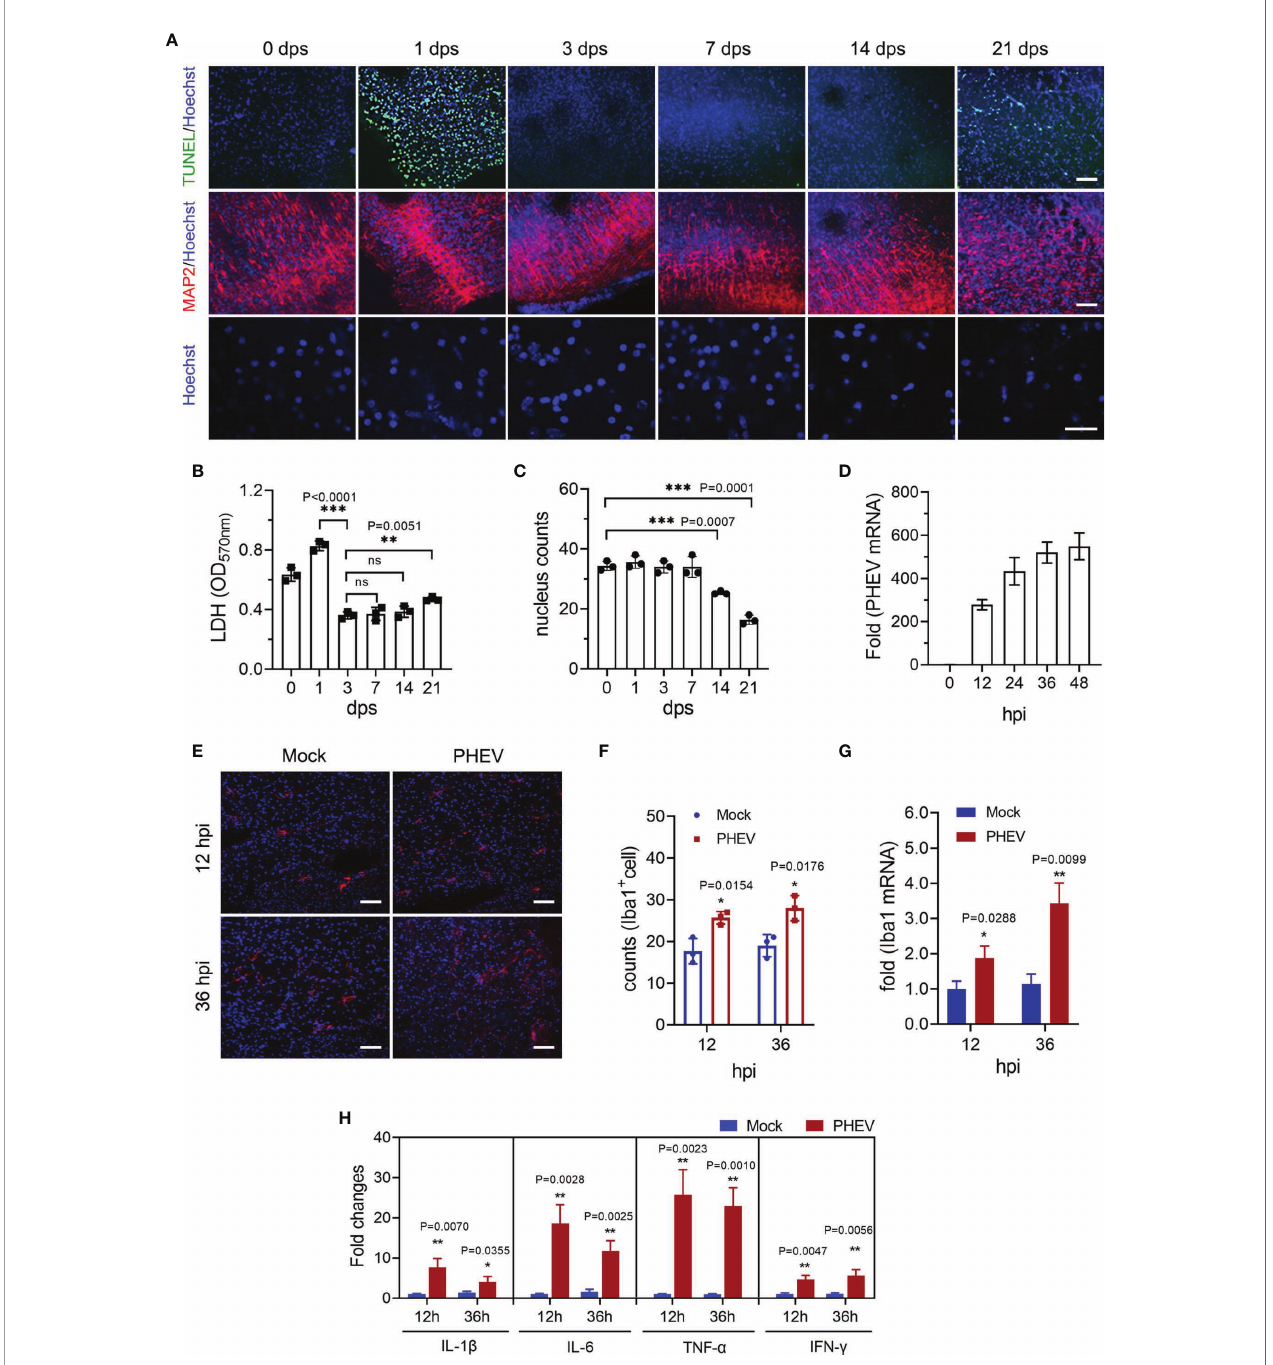
FIGURE 4 | PHEV drives moderate microglial activation in a brain slice culture model. (A) Evaluation of the brain slice culture (BSC) model. Brain slices were collected at 1 to 21 dps. TUNEL, MAP2, and Hoechst staining were performed. Bars, 200 m m. (B) Counts of TUNEL-labeled nucleus in the BSC model. (C) LDH release in the supernatant was detected daily. (D) PHEV mRNA was evaluated using qRT – PCR. (E) PHEV inoculation was performed at 3 dps and slices were subjected to immuno fl uorescence staining 12 and 36 h later. Bars, 200 m m. (F) Counts of Iba 1-labeled cells. (G) Iba 1 mRNA expression was detected using qRT – PCR at 12 and 36 hpi. (H) The levels of in fl ammatory cytokines were evaluated using qRT – PCR at 12 and 36 hpi. Student ’ s t test (*, P <0.05; **, P<0.01; ***, P<0.001). ns, Not Signi fi